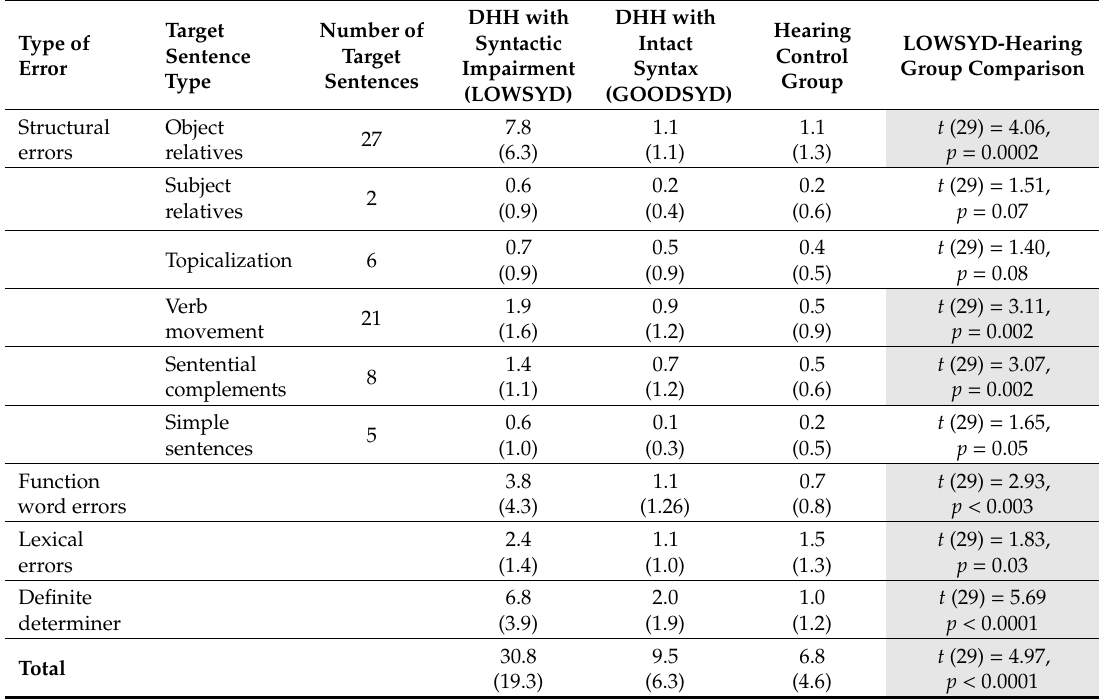
Table 4. Mean number (and SD) of reading errors per participant in reading paragraphs with syntactic movement in the two DHH groups and in the hearing control